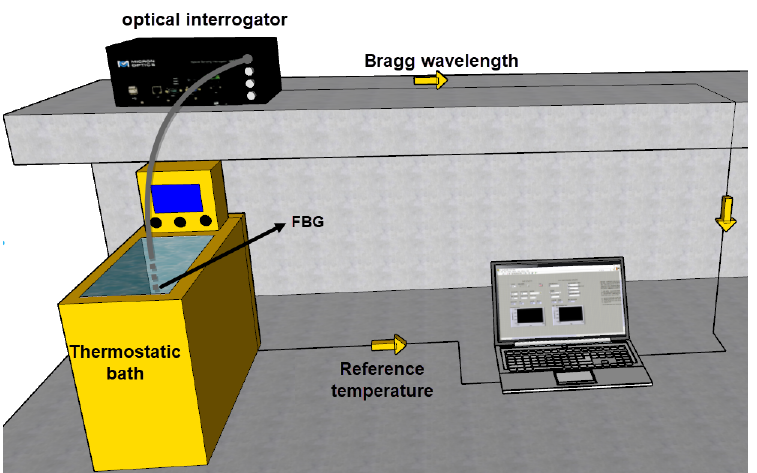
Figure 2. Experimental setup for the measurement of the HTR in liquids undergoing forced